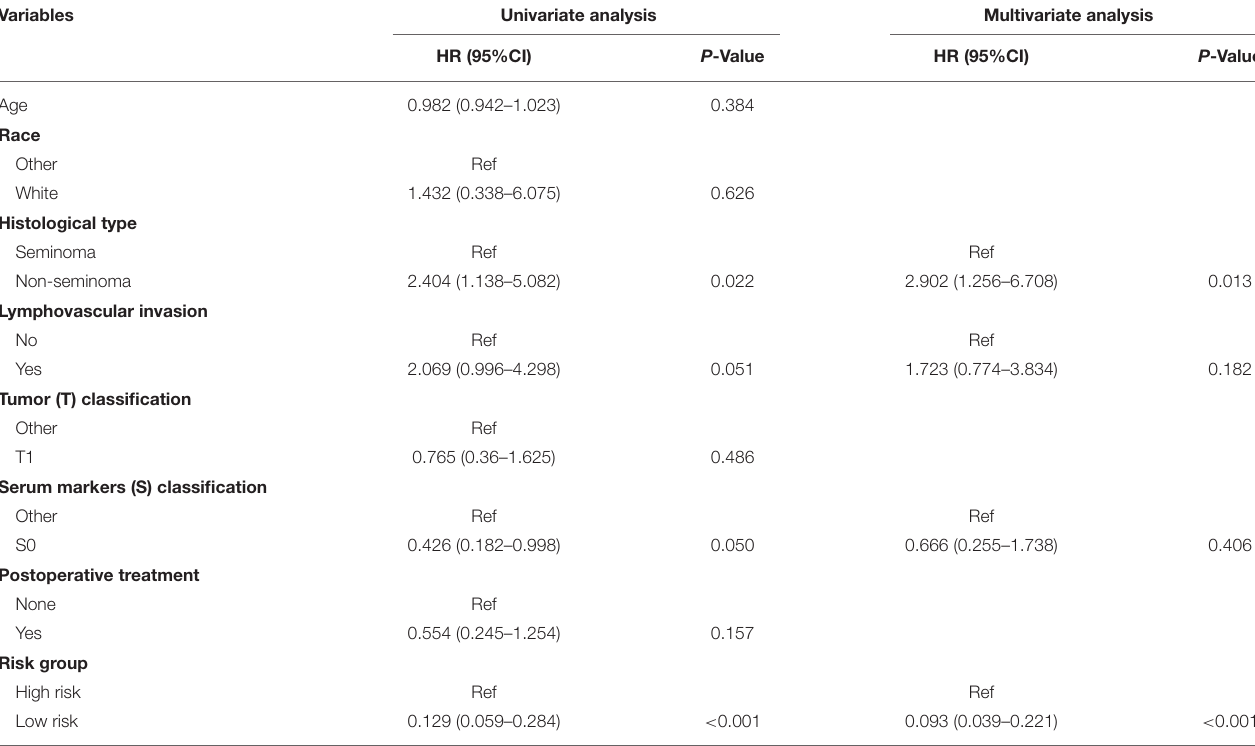
TABLE 3 | Univariate and multivariate Cox regression analyses of risk factors associated with Relapse free Survival. Variables Univariate analysis Multivariate